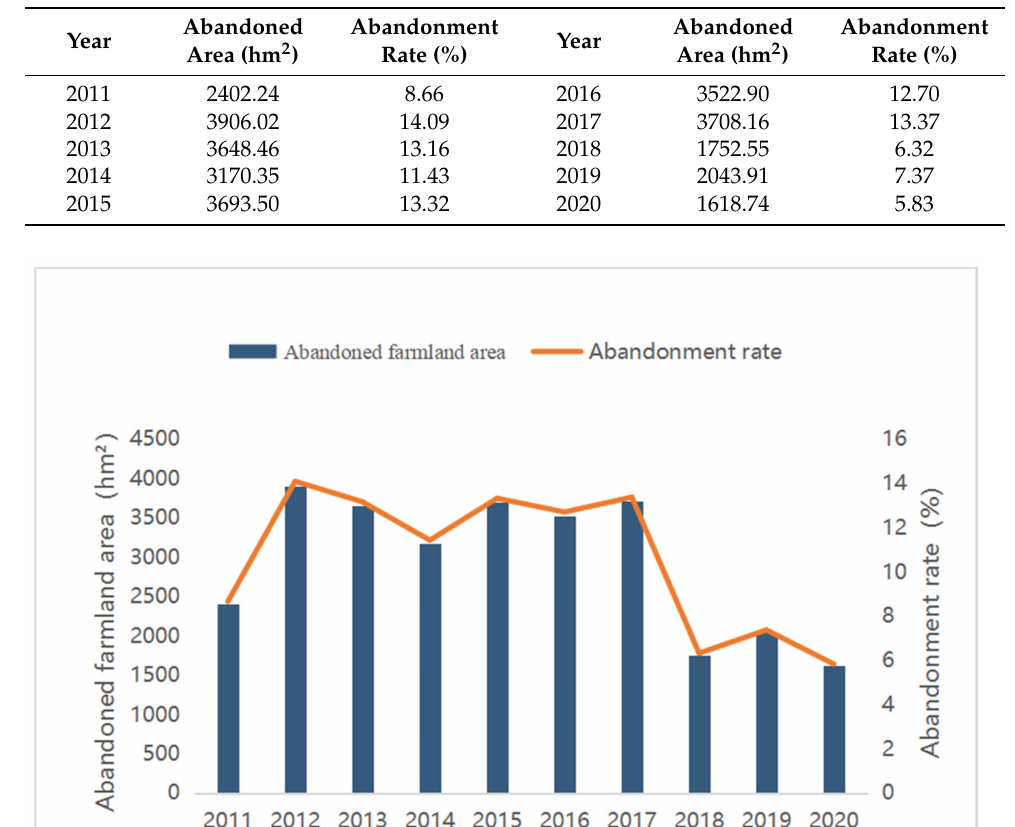
Table 3. Statistical results of the abandoned farmland in the study area from 2011 to 2020.